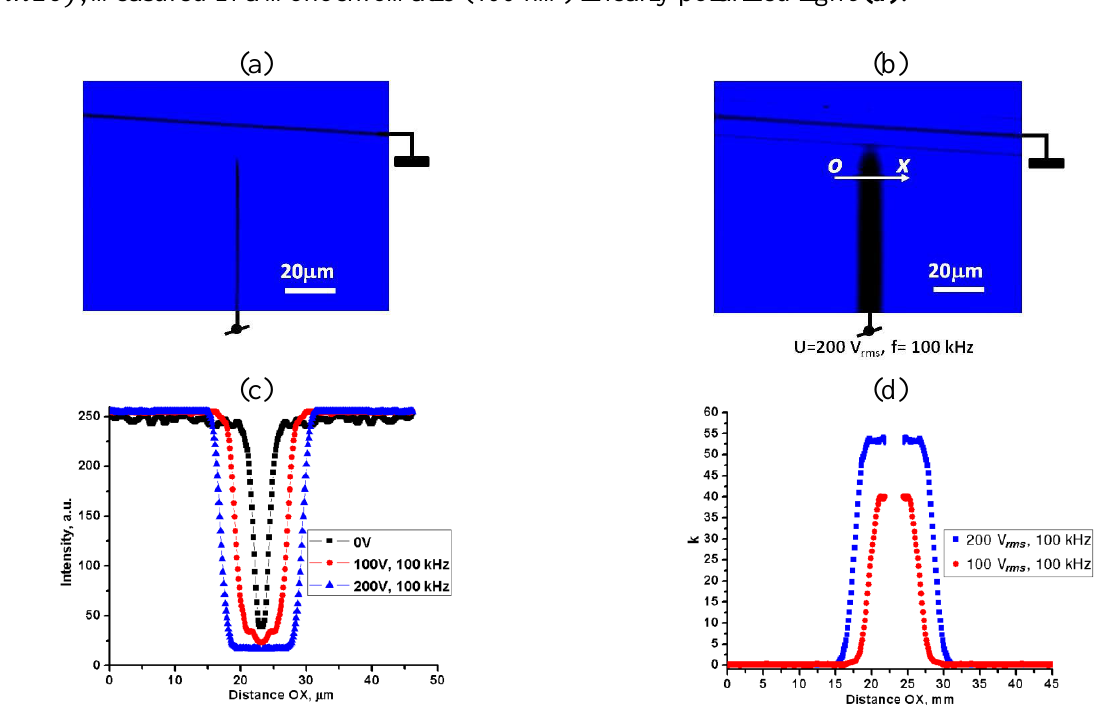
is off (a) and on (b) ; spatial profiles of transmitted light 𝑒 𝑥 = −𝑙𝑛𝑇 𝑥 𝐷 /(𝐴 460𝑛𝑚 ∙ 𝑑 ∙ 𝑁𝑅 ∥ 𝑐 𝑐